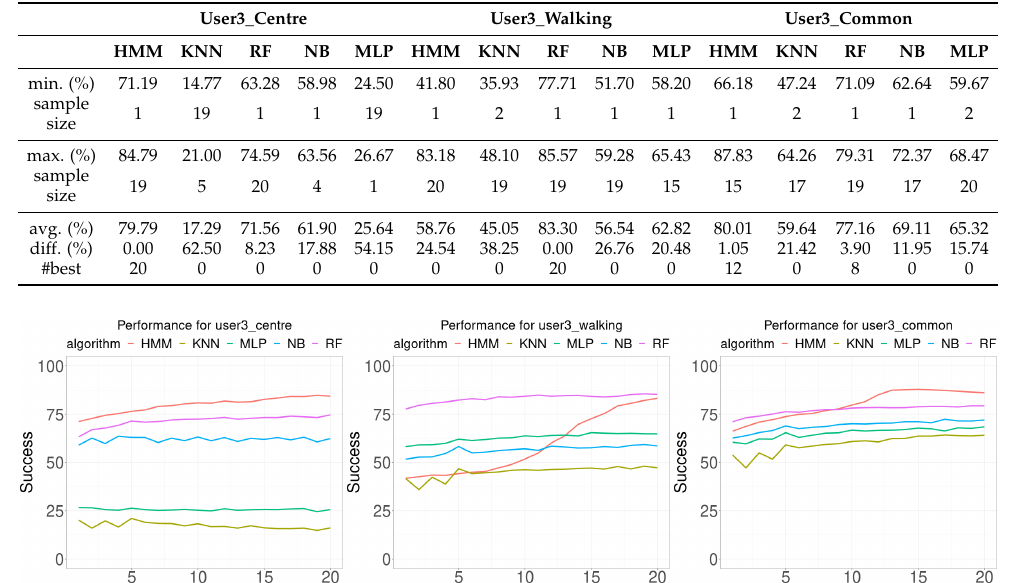
Table 5. Summary of the data shown in Figure 9. The rows for minimum (min.), maximum (max.), average (avg.), and difference (diff.) are given in percentages of successful classification experiments. The row labeled as size is for the corresponding sample size. The row labeled as #best is for the number of times the corresponding algorithm provided the best results.